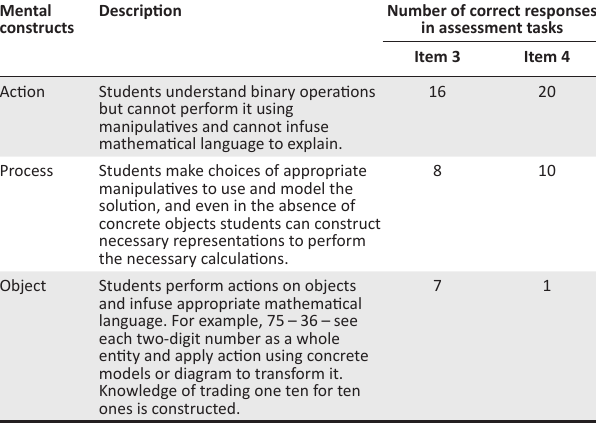
TABLE 3: Level of conceptualisation of the students’ use of manipulatives to model